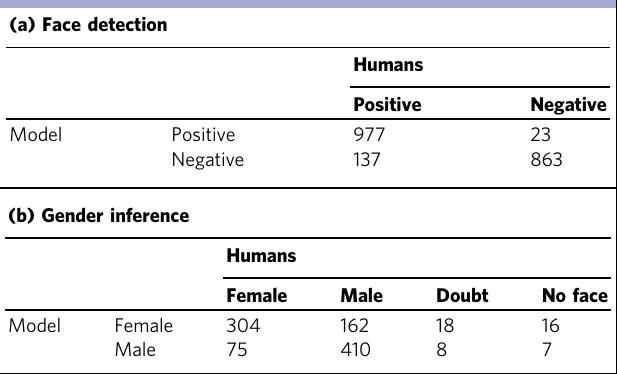
Table 1 Evaluation of the detection